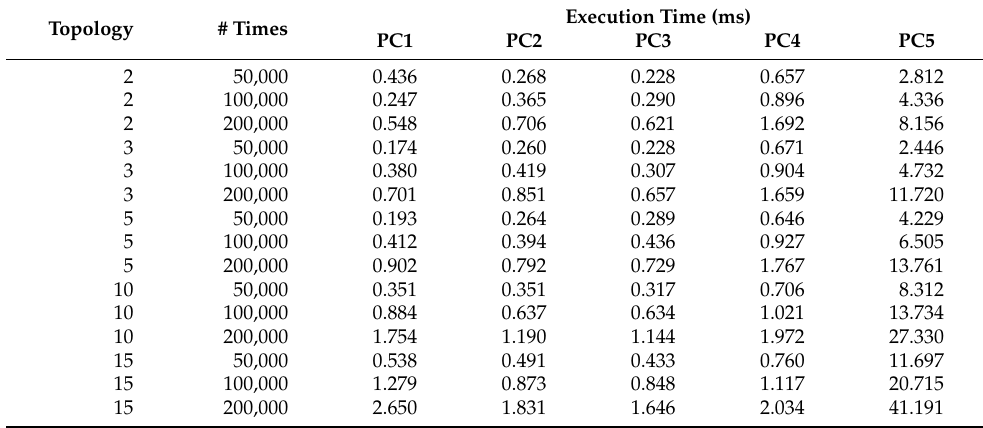
Table 5. Performance evaluation of series generic